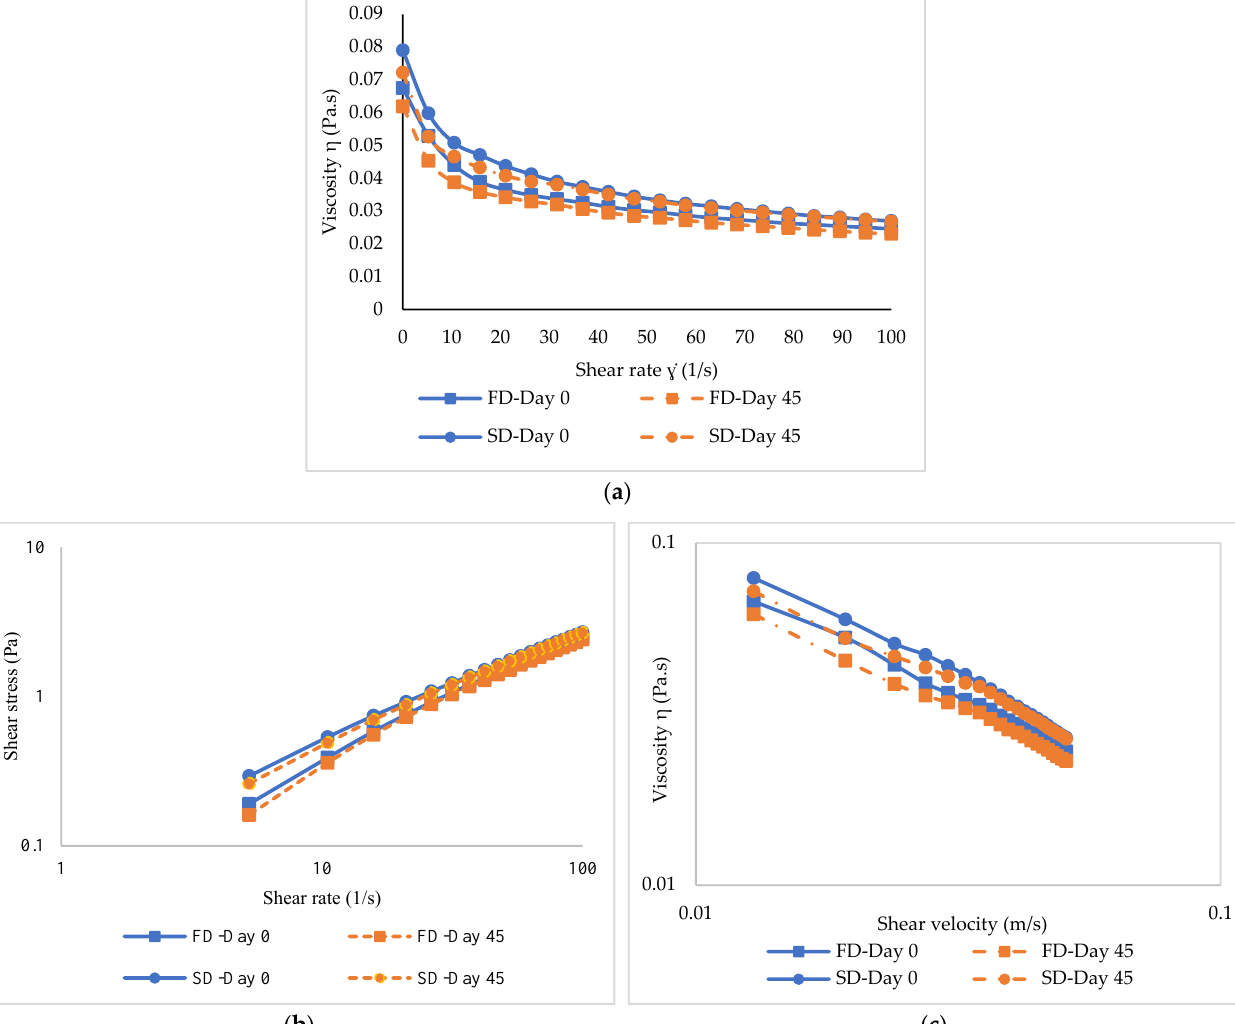
Figure 7. Viscosity ( a ) and flow curves ( b , c ) of emulsions stabilized by freeze-dried (FD) and spray- dried (SD) fish myofibrillar protein (FMP) modified with 0.5% tannic acid at day 0 and 45 of storage at 28 °C. The flow curves of both emulsions at day 0 and 45 are displayed in Figure 7b. The flow curves of the shear-thinning emulsions were linear on a log–log plot of shear stress versus shear rate, indicating pseudoplastic behavior. Hence, a power-law model could be fitted to each curve: 𝜏 = 𝑘𝛾 𝑛 where 𝜏 is the shear stress (Pa), 𝛾 is the shear rate (s −1 ), k is the fluid consistency index (Pa·s n ), and n is the flow behavior index. Generally, shear stress increased with augmenting shear rate, representing a non-Newtonian behavior [38]. The emulsions at day 45 had lower shear stress compared to day 0. This led to a decrease in flow behavior after storage. Viscos- ity represents the ratio of shear stress to shear rate [38]. Shear stress gradually increased with the coincidental decrease in viscosity [22]. Overall, the SD-FMP-0.5TA emulsion showed greater viscosity at a high shear rate than the FD-FMP-0.5TA emulsion at both storage times.